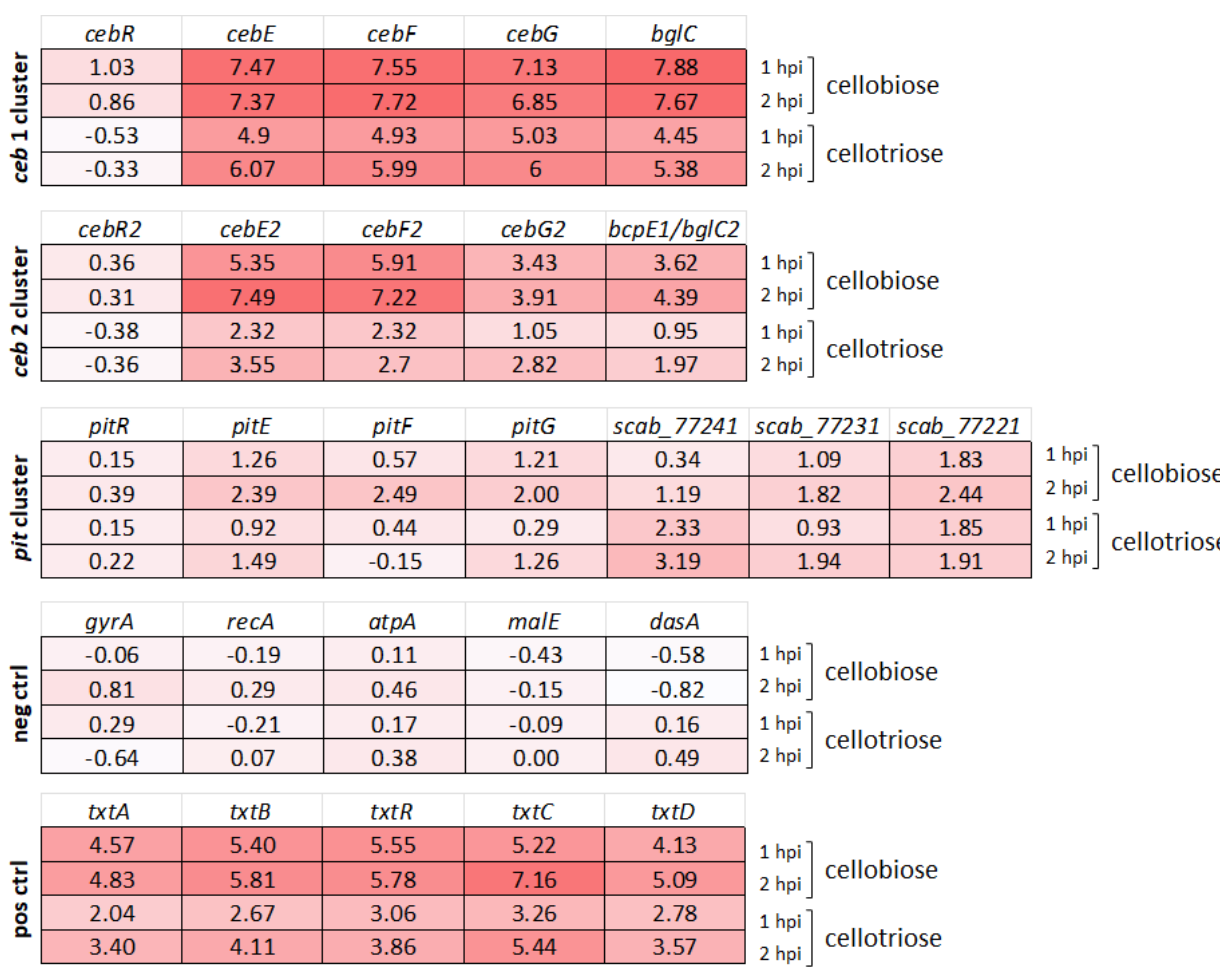
Figure 3. Transcriptional response of known and putative elicitor transporter clusters upon cellobiose and cellotriose supply. Values in the heatmap are the mean of Log2 fold-change. The expression changes of housekeeping genes gyrA , recA , atpA , and of bxlE and dasA encoding the xylobiose and N - N’ -diacetylchitobiose ABC-type sugar-binding proteins, respectively, were used as negative controls (for which the expression is known to be independent of either cellobiose or cellotriose). The expression changes of five genes of the thaxtomin biosynthetic gene cluster ( txt ) were used as positive controls. abbreviations: neg ctrl, negative controls; pos ctrl, positive controls; hpi, hour(s) post induction by either cellobiose or cellotriose.